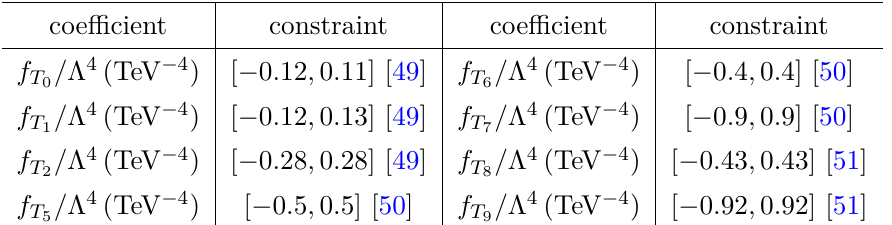
coefficients obtained at 95% i